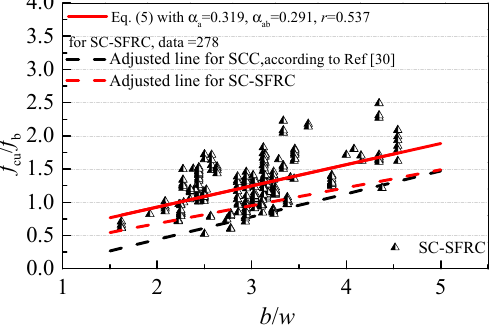
Figure 8. The fitting process of α a and α ab .